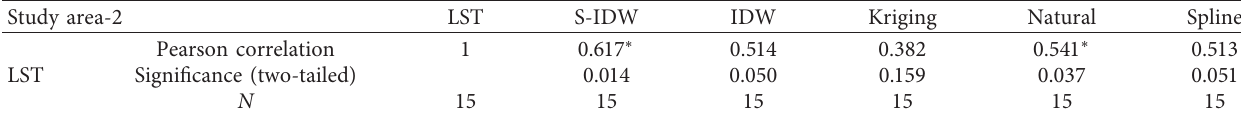
Table 17: Correlation analysis of interpolation results of 5 kinds of interpolation methods on Apr. 19, 2018.